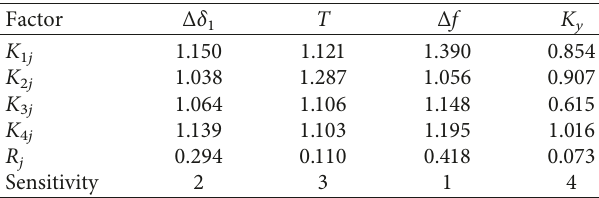
Table 3: Range analysis